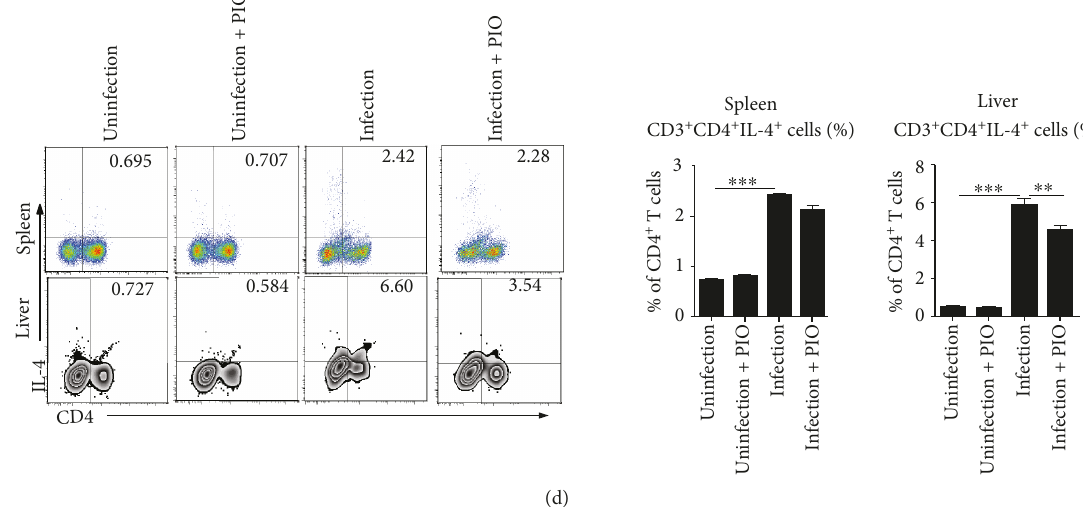
Figure 2: The expression of regulatory cells and e ff ector Th1/Th2 cells after pioglitazone treatment of S. japonicum infection. (a – d) Single cell suspensions of mouse spleen or liver from pioglitazone-treated mice infected with or without S. japonicum were prepared. (a) The absolute numbers of CD4 + T cells both in the liver and spleen of mice were calculated as the proportion of CD3 + CD4 + T cells in the leukocyte gate multiplied by the total cell count. (b) Cells were stained with CD25-APC and CD4-FITC and then intracellularly stained with PE-conjugated antibodies against Foxp3 for FACS analysis of CD4 + CD25 + Foxp3 + (Treg). (c, d) Cells were stained with CD3-APC and CD4-FITC and then intracellularly stained with PE-conjugated antibodies against IFN- γ or IL-4 for FACS analysis of CD3 + CD4 + IFN- γ + (Th1) or CD3 + CD4 + IL-4 + (Th2) cells, respectively. Data are expressed as the mean ± SD of 12 mice for each group from three independent experiments (ANOVA/LSD), ∗ P < 0 05 , ∗∗ P < 0 01 , and ∗∗∗ P < 0 001